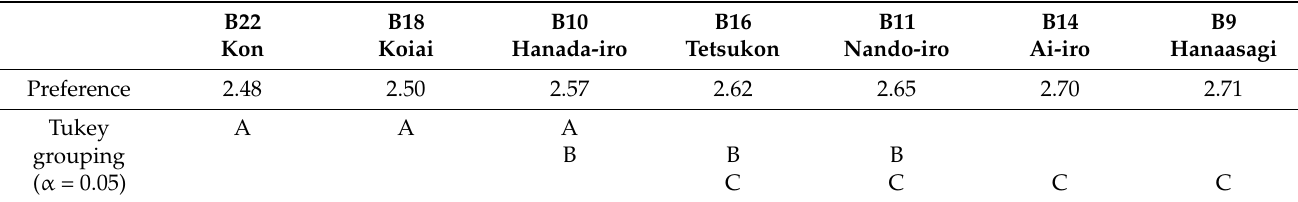
Table 4. Tukey grouping of preferences for different shades of blue.